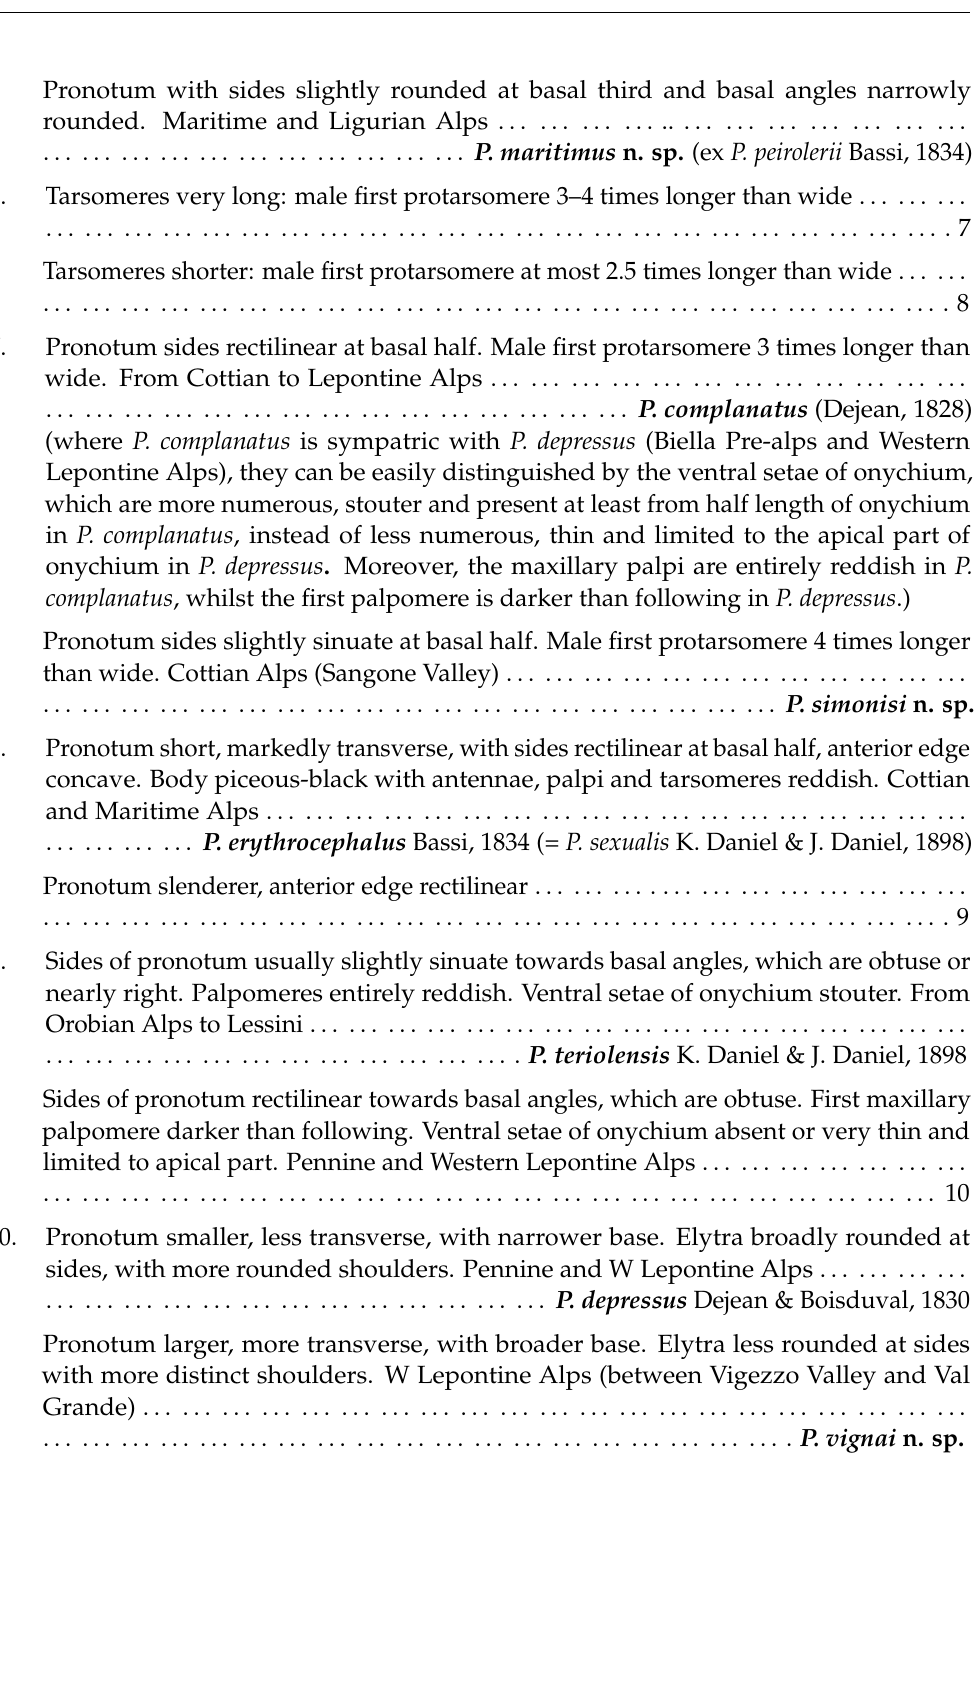
- Pronotum with sides slightly rounded at basal third and basal angles narrowly